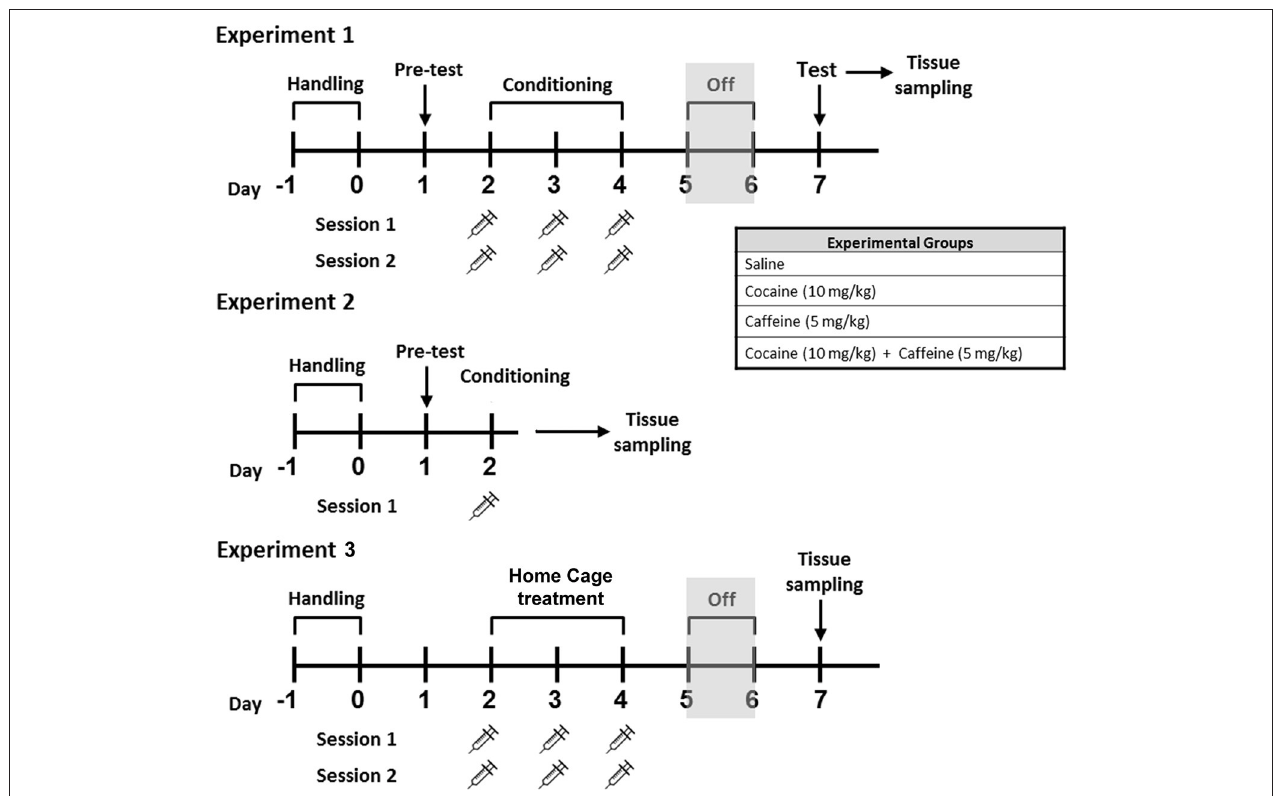
FIGURE 1 | Schematic representation of the experimental treatments for Experiments #1, #2, and #3 Male C57BL/6 mice were subjected to CPP learning with caffeine 5 mg/kg (CAF), cocaine 10 mg/kg (COC), and their combination (5 mg/kg caffeine + 10 mg/kg cocaine, CAF-COC). Tissue samples for RT-PCR were taken immediately after the first conditioning CPP session, (Experiment #2), or immediately after CPP test session, (Experiment #1). For Experiment #3, brain tissue was obtained 48h after last injection.